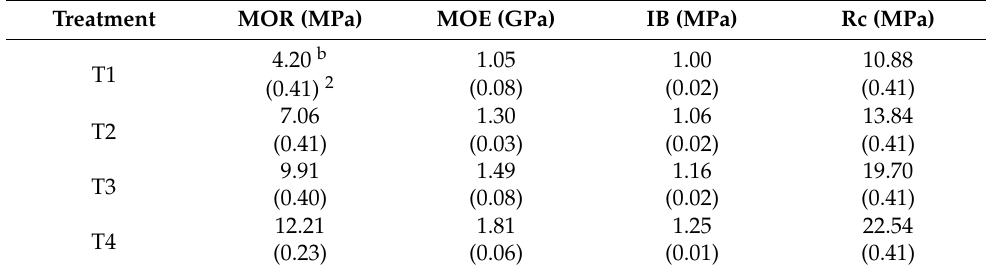
Table 5. Mechanical properties.